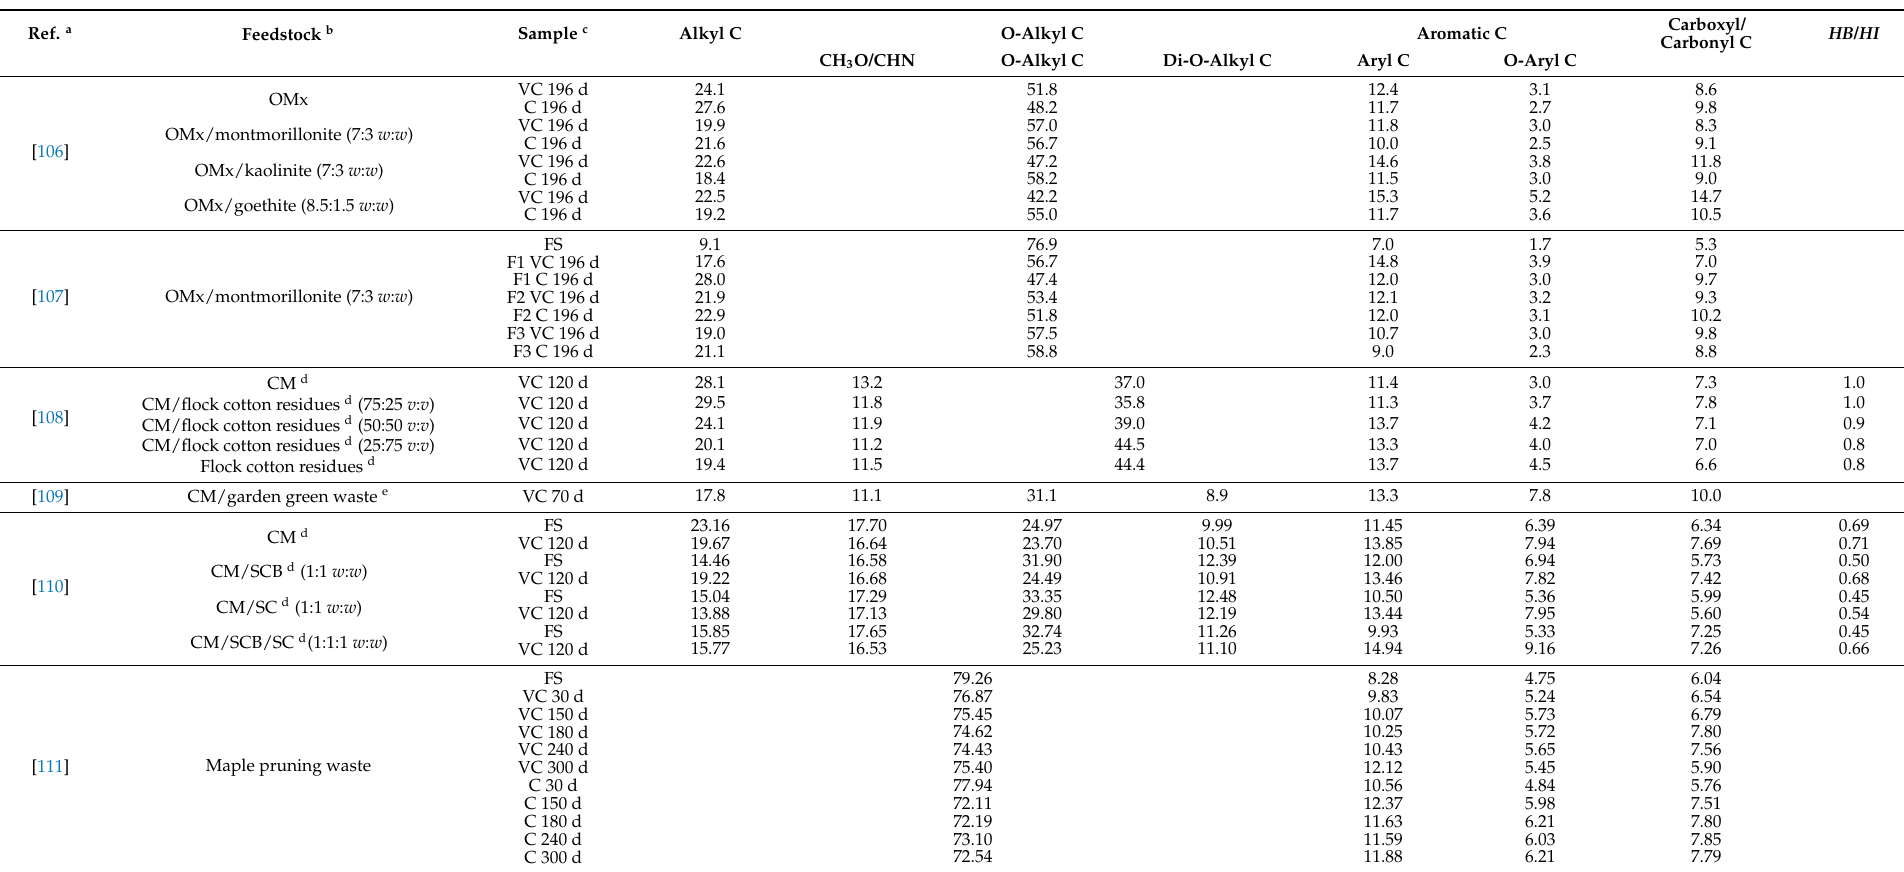
Table 4. Relative areas (% of total area) of the regions of 13 C CP-MAS NMR spectra of vermicomposts and corresponding feedstocks reported in the literature; when available, the hydrophobic index, HB/HI , is also